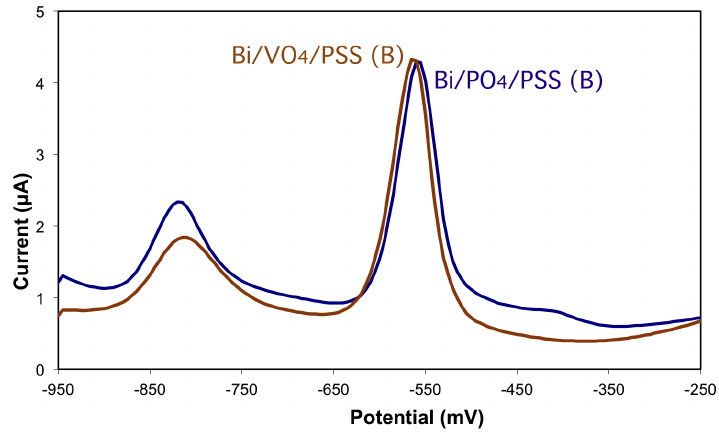
Figure 5. Comparison of differential-pulse stripping profiles of 50 ug/L Cd and Pb using Bi/PO 4 /PSS(B) and Bi/VO 4 /PSS(B) electrodes.